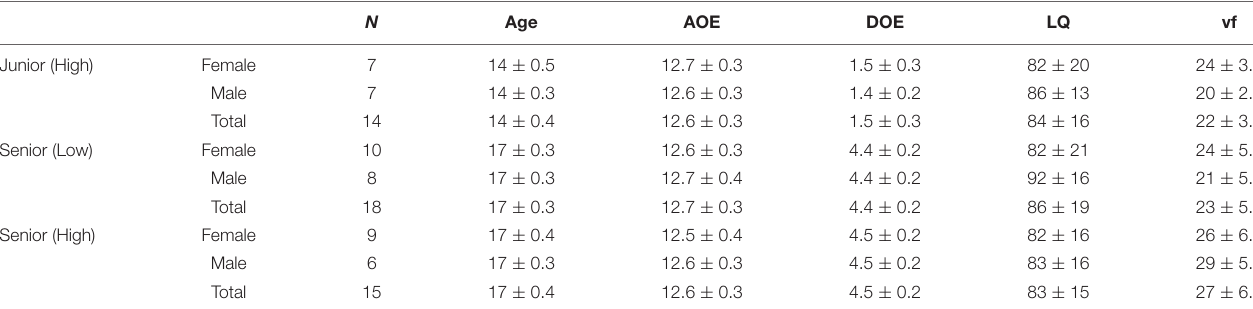
TABLE 1 | Demographic details of the participants in each